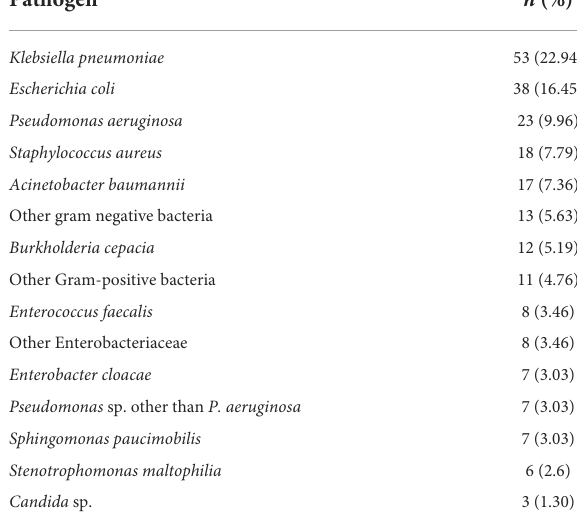
TABLE 1 Characteristics of patients and bloodstream infections in study population.